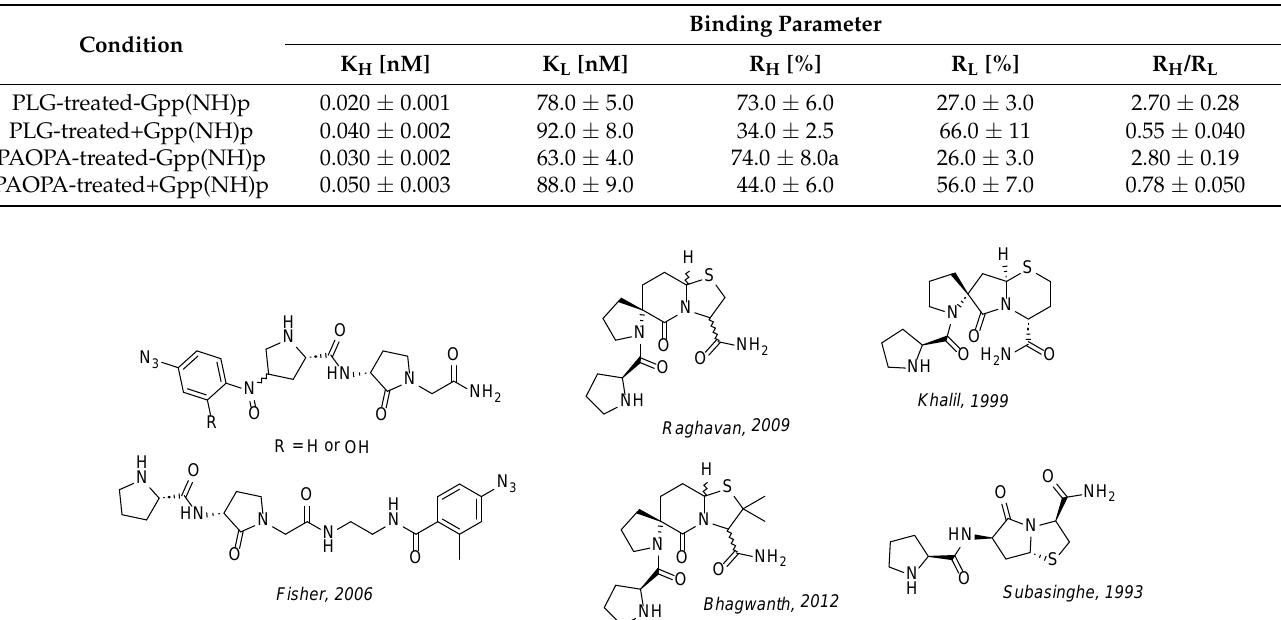
Table 5. Modulation of [ 3 H]spiperone/N-n-Propylnorapomorphine (NPA) at D 2L receptors by PLG and PAOPA [45]. K H and K L represent the inhibition constant (K i ) of agonist, calculated from the high-affinity and low-affinity component of [ 3 H]spiroperidol binding, respectively. Percent R H and percent R L are, respectively, the percentage of sites in high- or low-affinity form for the agonist. R H /R L is the ratio of the two percentages. Each value is an average of three to four separate experiments ± S.E.M., carried out in duplicate or triplicate. The concentration of PLG used was 1 μM and the concentration of PAOPA was 1 nM. Gpp(NH)p: guanosine 5′ -( β , γ -imido)triphosphate.